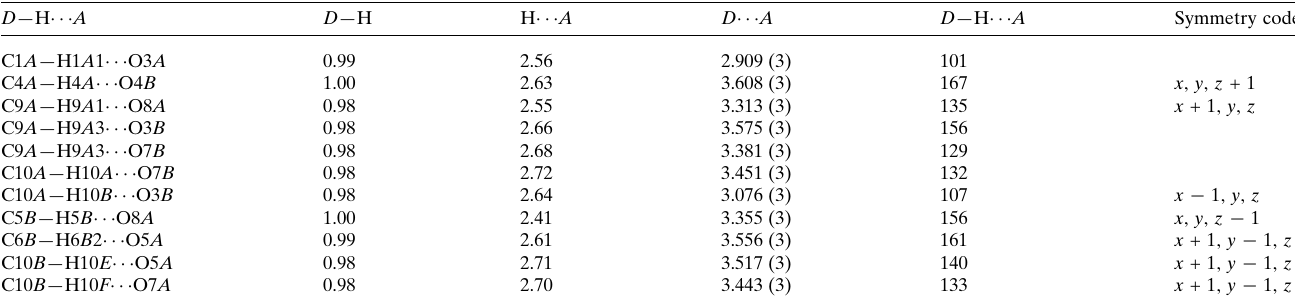
Table 2 Suspected C—H (cid:5)(cid:5)(cid:5) O contacts (A˚ , (cid:3) ) in (I). D —H (cid:5)(cid:5)(cid:5) A D